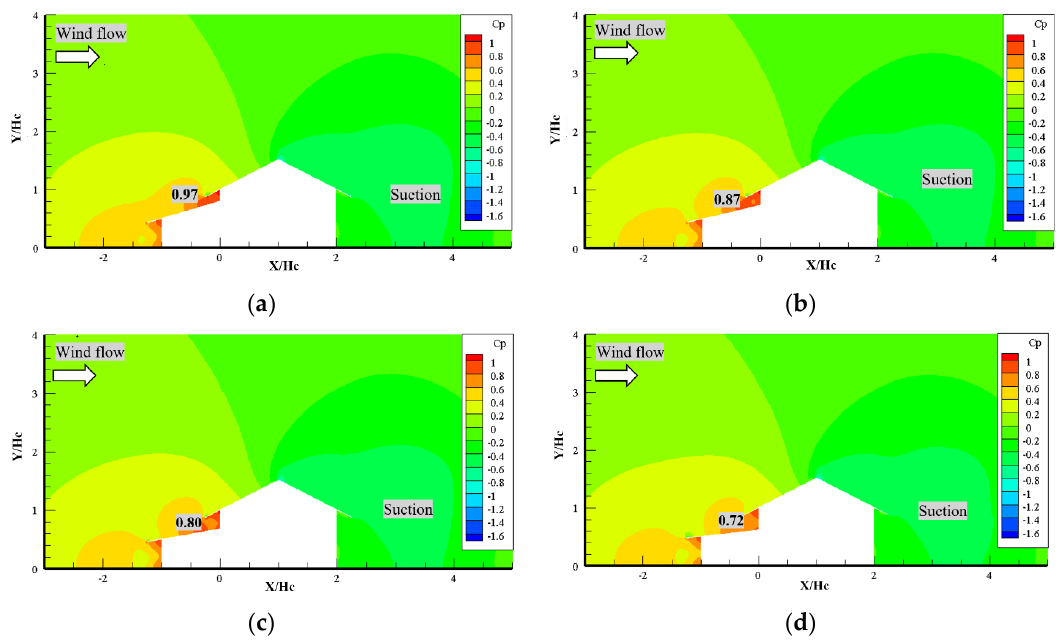
Figure 16. The pressure coefficient contours along the transverse profile with gap heights of ( a ) 0.25 m; ( b ) 0.5 m; ( c ) 0.75 m; and ( d ) 1.0 m.